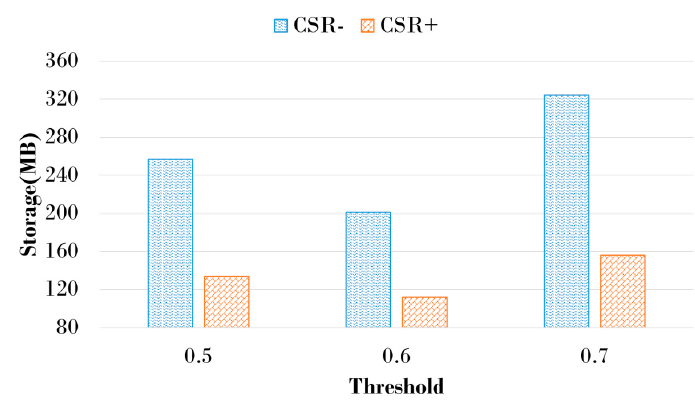
Figure 11. Storage usages using or without modified CSR.